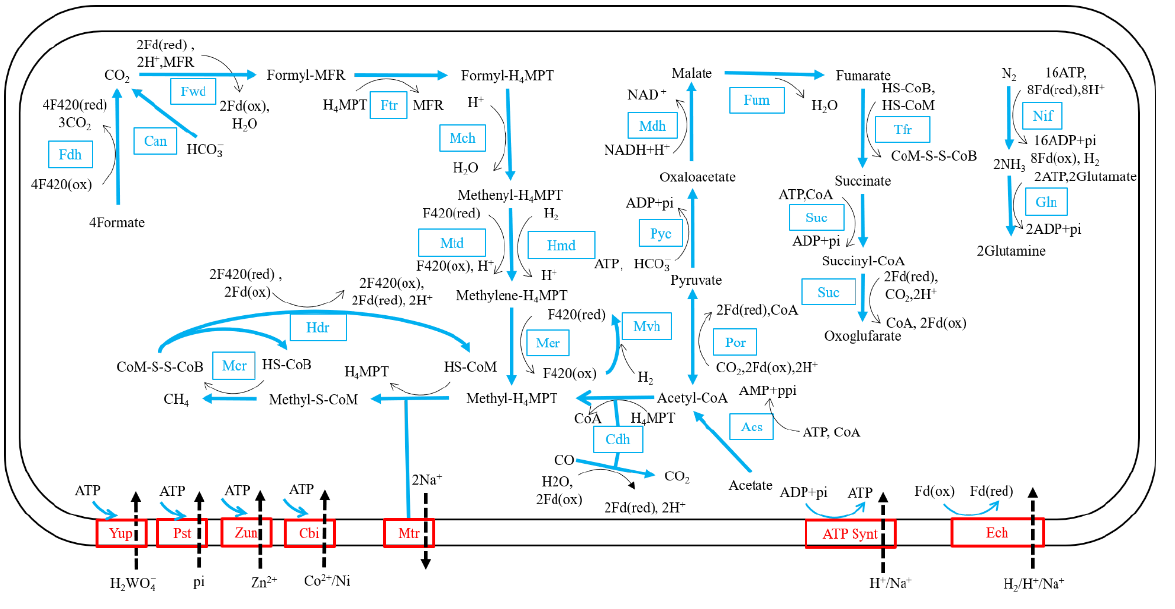
Figure 6. Reconstructed metabolic pathways of M. tengchongensis DL9LZB001. We reconstructed the main pathways based on the KEGG annotation. All enzymes and reaction directions are marked in blue, except for enzymes belonging to transporters which are marked in red with dashed lines to show transporting directions.